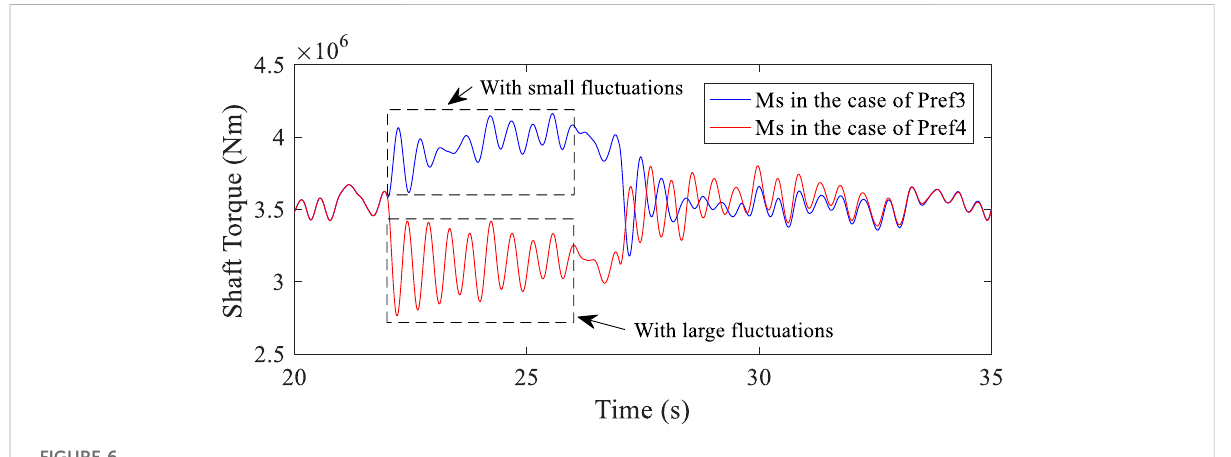
FIGURE 6 Change curves of M s under different reference power values.